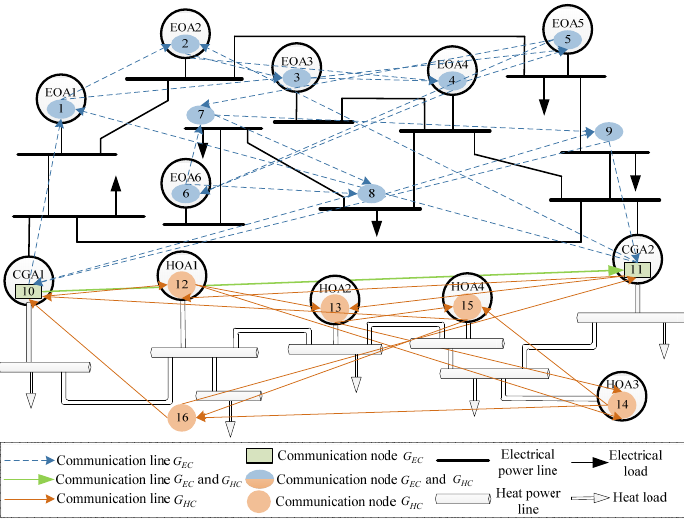
Figure 3. The 16 ‐ bus test system. Figure 3. The 16-bus test